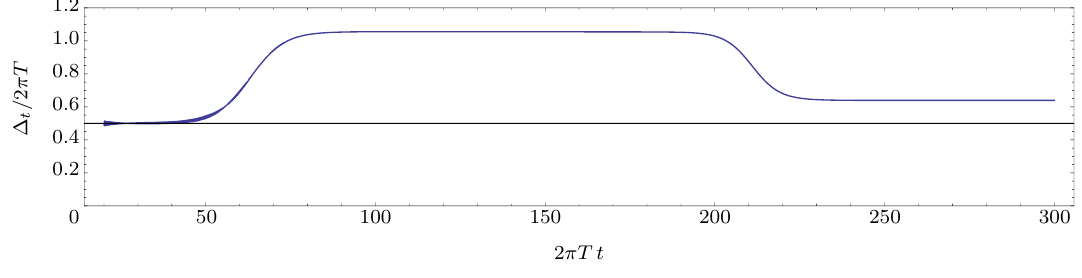
Figure 3. Time evolution of (cid:1) t = (cid:22) (cid:0) @ t 0 for the normal-to-condensed quench (cid:20) nc